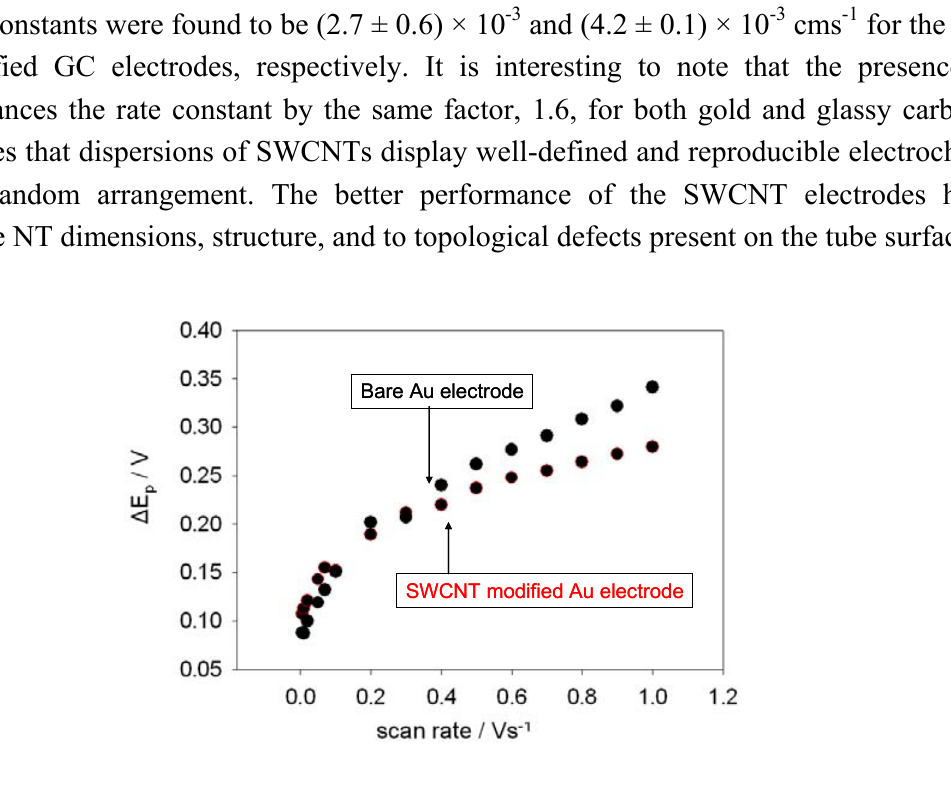
Figure 6. The variation of peak separation with scan rate. The electrolyte used was a 1mM solution of ferricyanide in 50 mM KCl in a 50 mM Phosphate buffer solution (pH